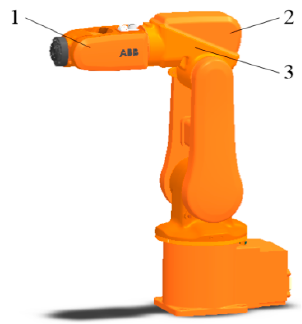
Figure 10. Model of the IRB120 robot.